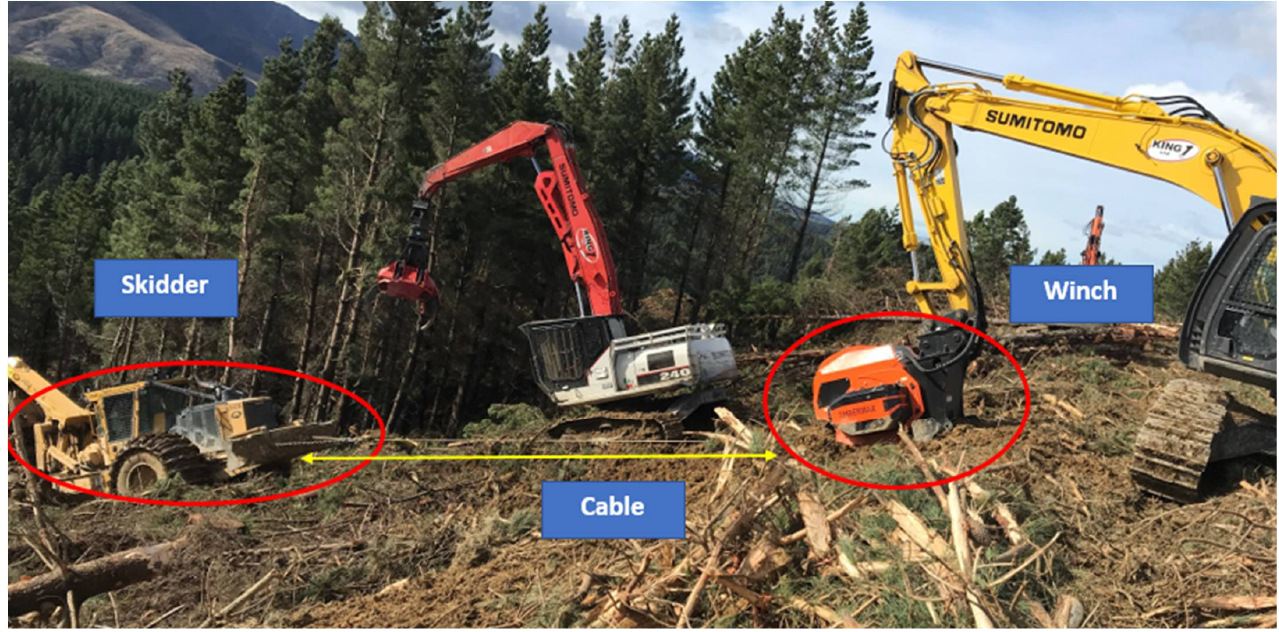
Figure 1. The Tigercat Grapple Skidder climbing towards the landing ( left ), the TimberMax winch on the edge of the landing ( right ) and the cable connecting them. The tracked loader in the centre is moving downslope to prepare the loads for the skidder.